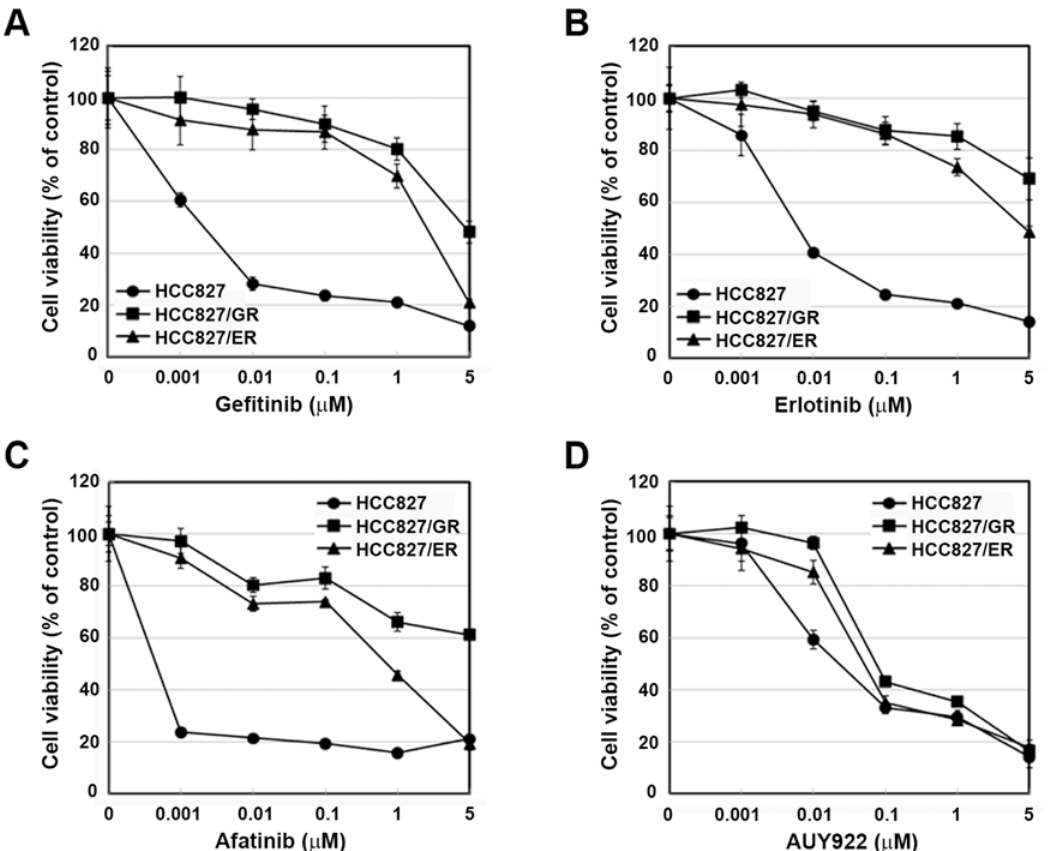
Fig 1. EGFR-TKI and AUY922 cytotoxicity in parental HCC827 and resistant cell lines. Cells were treated with the indicated doses of gefitinib, erlotinib, afatinib, or AUY922 for 72 hours in medium containing 1% FBS. Cell viability was determined using the MTT